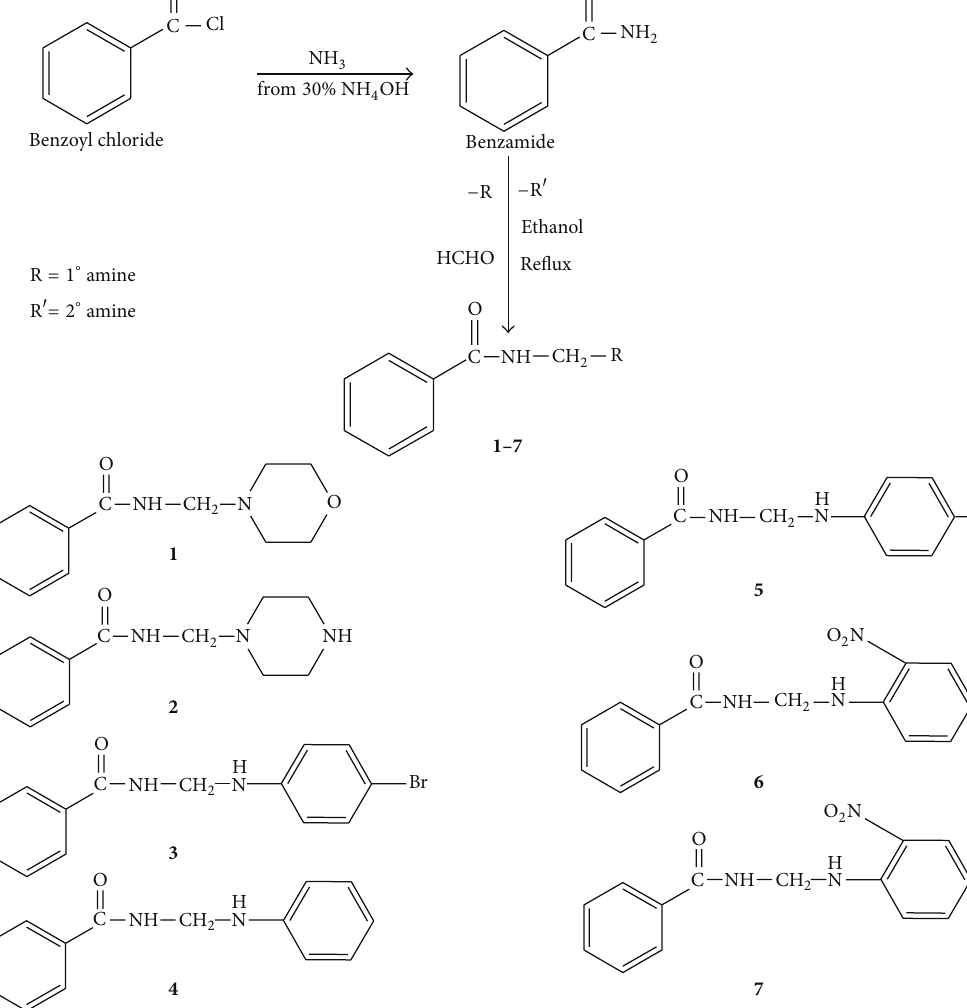
Figure 1: Synthesis of benzamide substituted Mannich bases ( 1 – 7